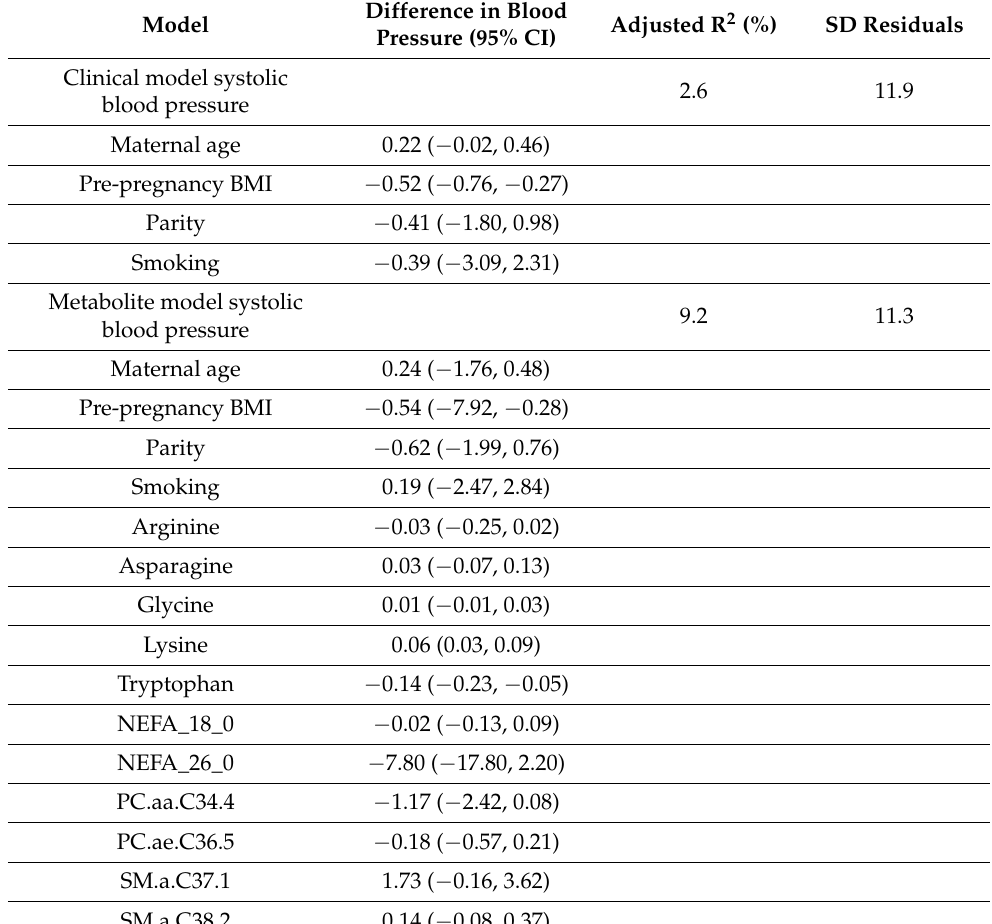
Table 2. Selected models for the prediction of systolic and diastolic blood